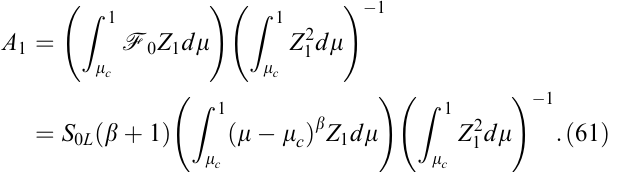
Fig. 2. The dependence of fluxes of trapped and precipitated electrons on (cid:117) in the case of strong di(cid:128)usion; (cid:108) (cid:255) 1